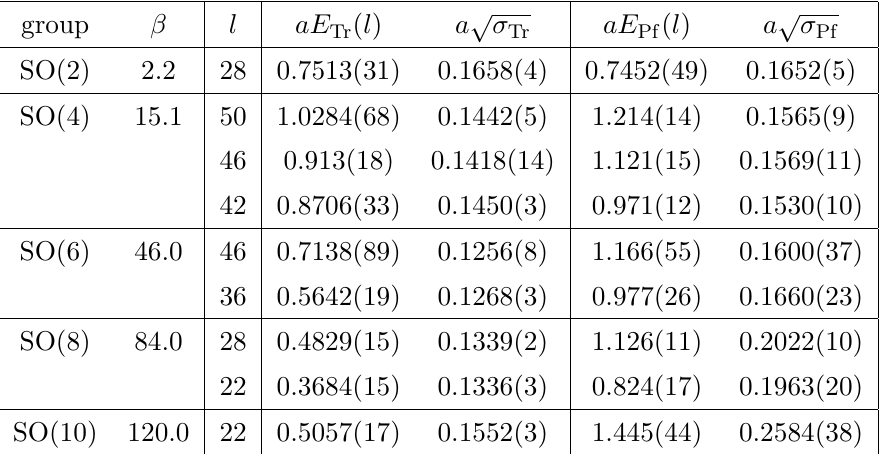
Table 7 . Energy and resulting string tension of lightest (cid:13)ux loop of length l in the Trace and Pfa(cid:14)an sectors for the groups shown and for our largest valuesof l . The string tensions have been extracted using the simple ‘Nambu-Goto’ formula in eq.